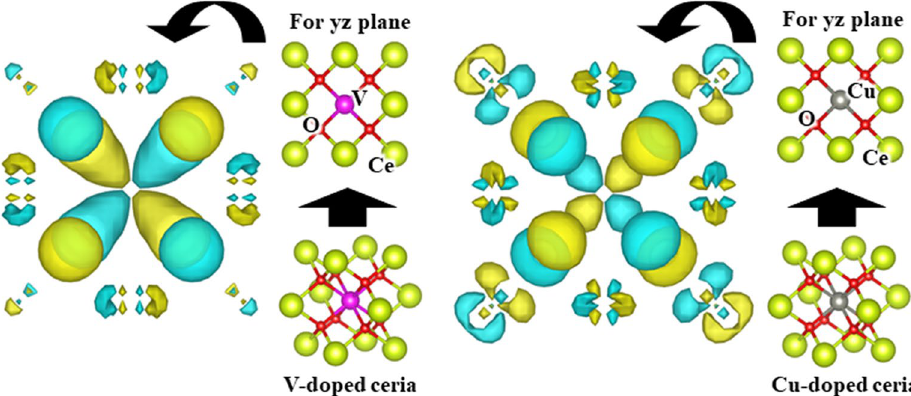
Figure 12. Comparison of the wave functions (visualized by VESTA) of the bonding orbitals: t 2g (# 26) in V doped and Cu doped ceria are visualized, the isosurface level is set to 0.025 for